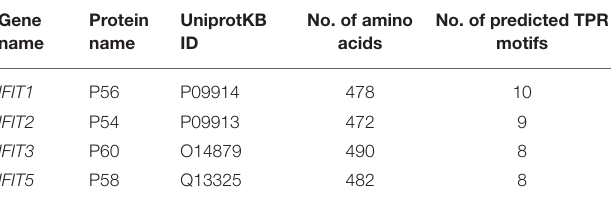
TABLE 2 | Summary of Human IFIT gene encoded